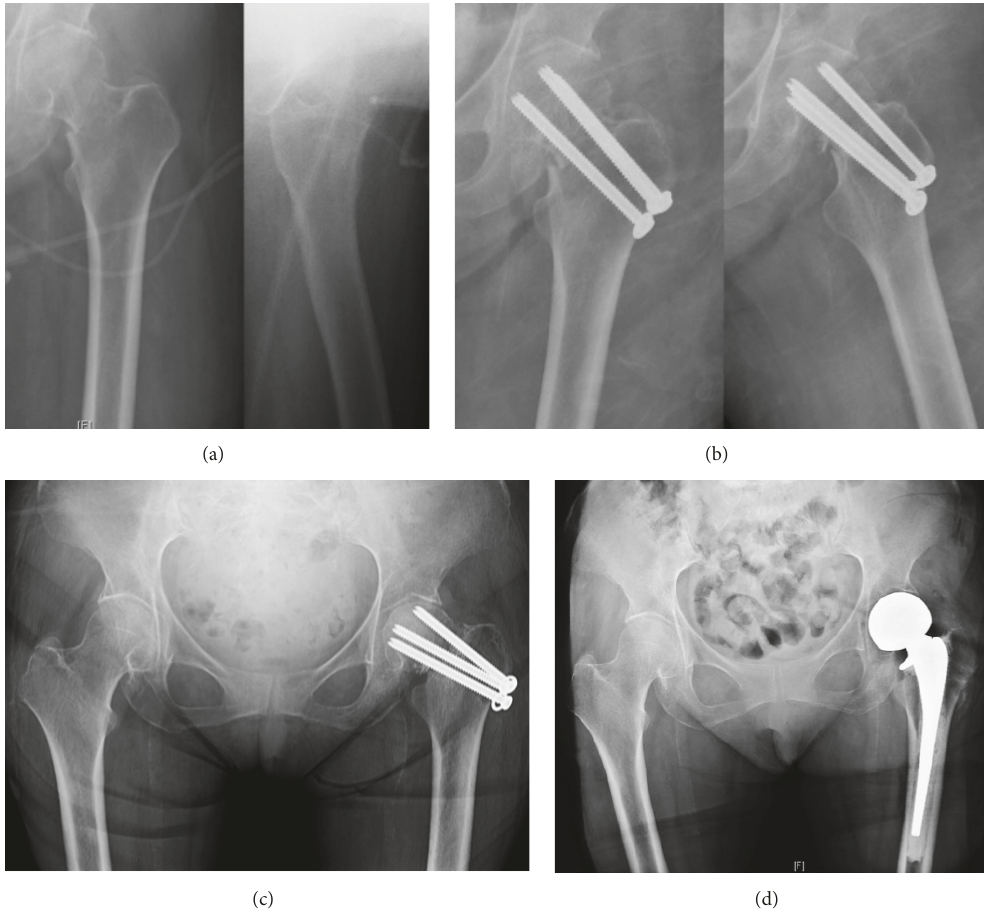
Figure 1: (a) A 61-year-old female sustained a syncopal fall at home resulting in a displaced left transcervical femoral neck fracture. She has a history of multiple medical comorbidities including end-stage renal disease on hemodialysis, diabetes mellitus, and hypertension. She subsequently went into PEA arrest twice during transport to the hospital. She was intubated and sedated on arrival. She remained critically injured in the Intensive Care Unit and was deemed an extremely high risk for surgery; therefore surgical intervention was delayed until the patient was medically stable. On hospital day 8, the patient was cleared by the medical service for surgical intervention of her displaced femoral neck fracture, and after extensive conversation with the patient and her family, consent was obtained and surgery was pursued with the plan for hemiarthroplasty given her fracture displacement and delayed presentation to the OR. After induction of anesthesia, the patient was deemed too instable to undergo a hemiarthroplasty, so conversion to closed reduction with percutaneous cannulated screws was chosen, aware of the chance of failure, but choosing this given her medical instability and high risk (b). She was followed in the clinic and over the following 7 months continued to have groin pain with ambulation and radiographic signs of hardware failure and nonunion (c). During this time, she had extensive medical optimization in anticipation of revision surgery. When deemed medically optimized and cleared for surgery, after discussion with the patient and her family, she was brought back to the OR for hardware removal and left hip hemiarthroplasty (d). She tolerated the procedure without complications and is ambulating with minimal pain